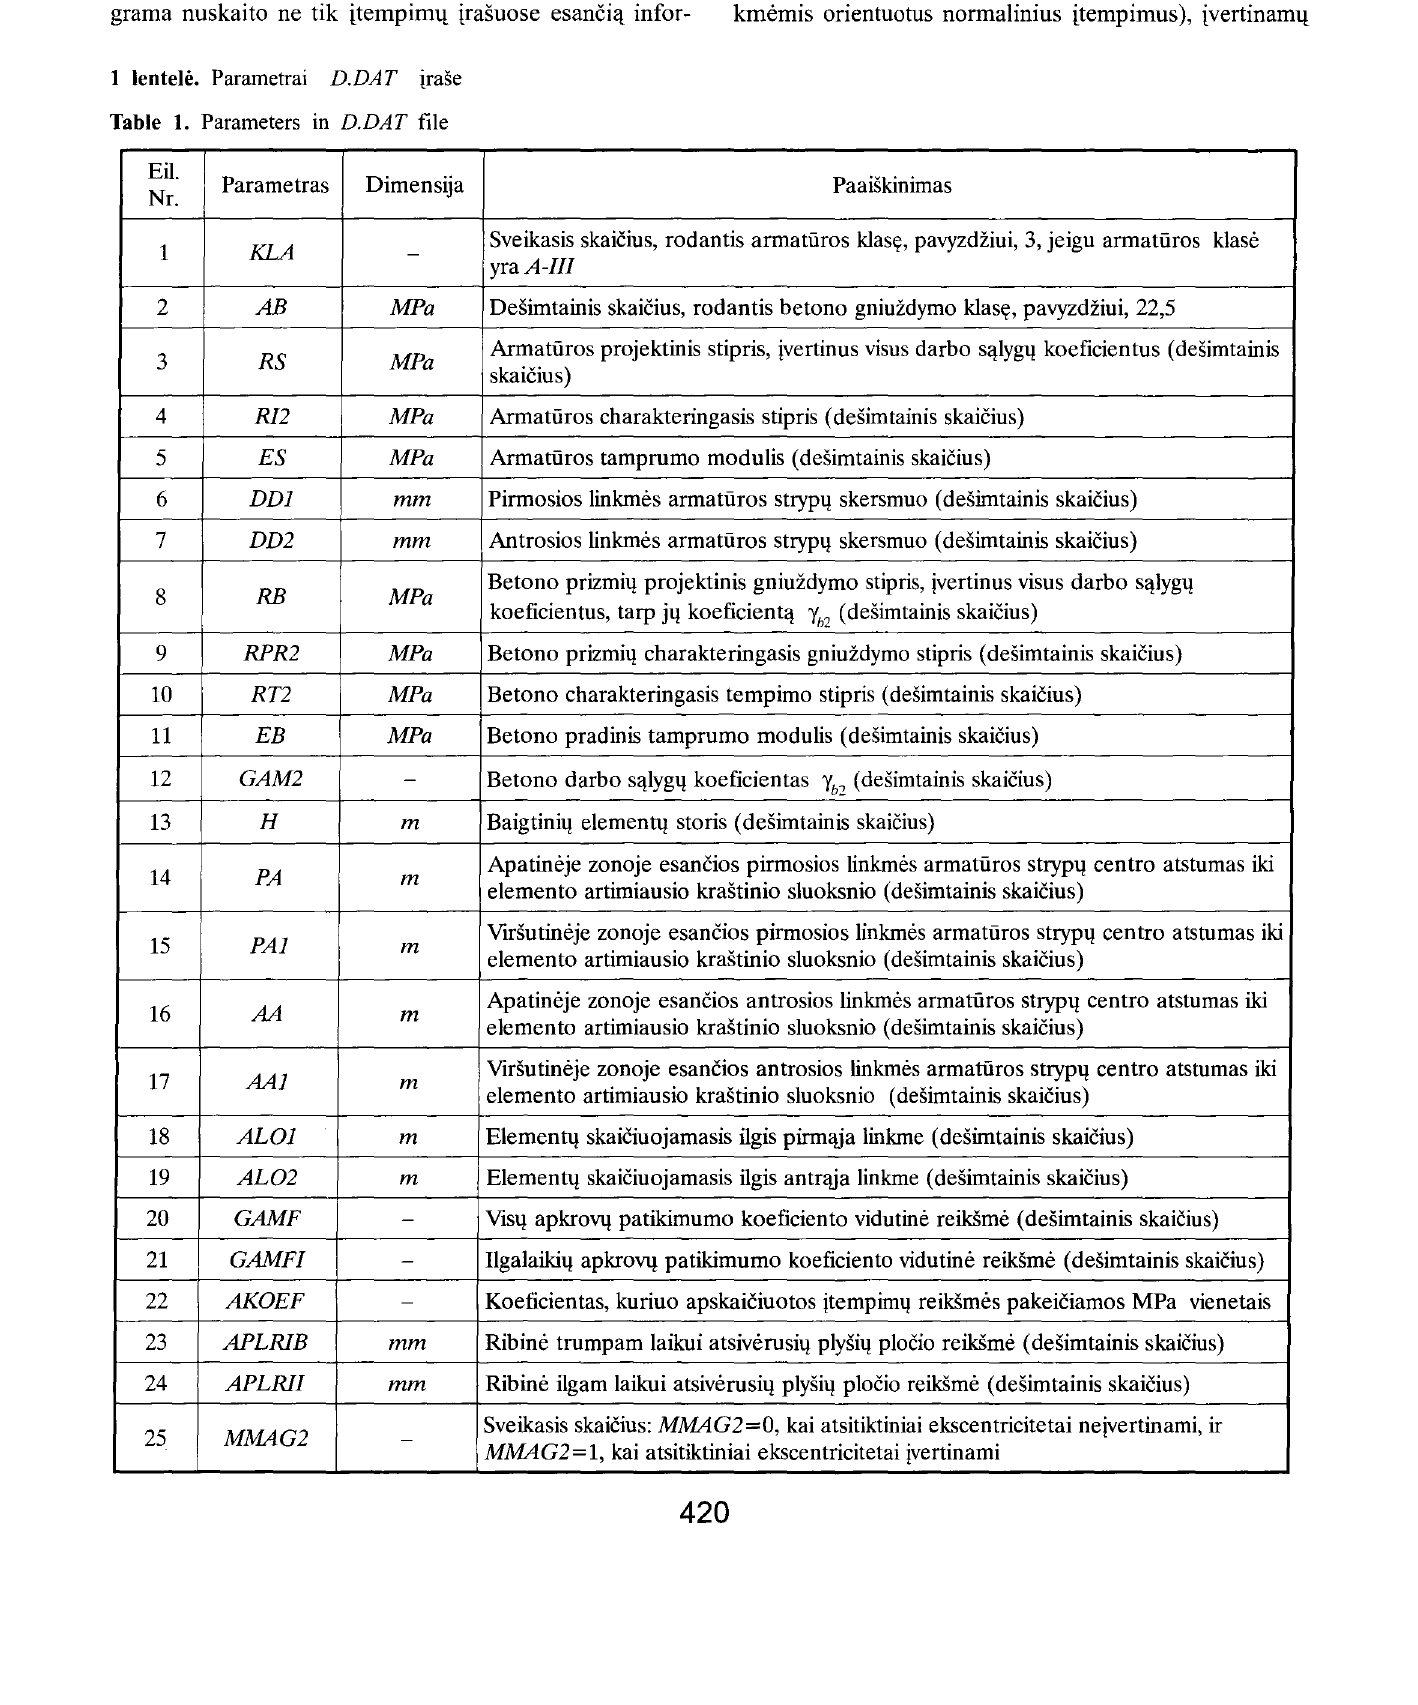
Table 1. Parameters in D.DAT file Eil. Parametras Dimensija Paaiskinimas